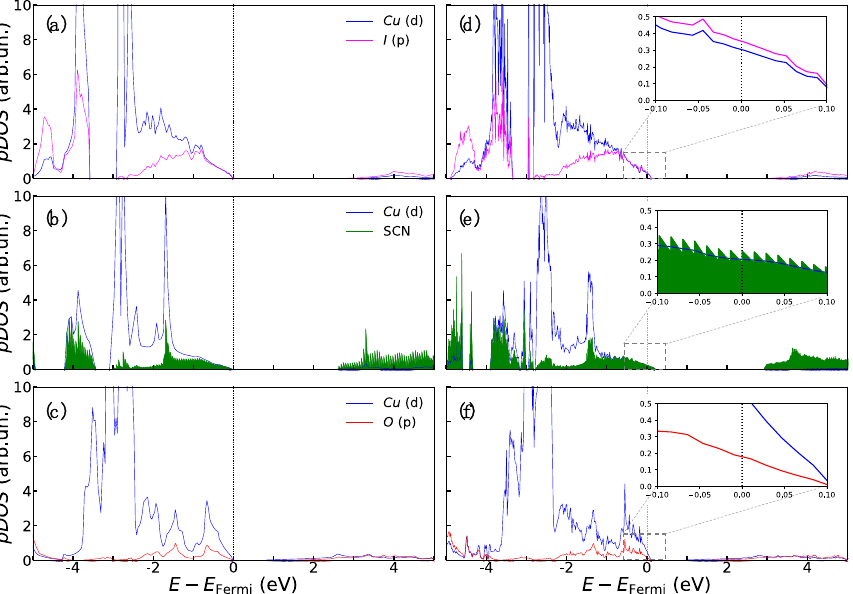
Figure 2. Atom- and orbital angular momentum-projected density of states (pDOS) for the bulk structures of CuI ( a , d ), CuSCN ( b , e ) and Cu 2 O ( c , f ) calculated at the PBE+U level of theory. The pDOS of the left panel refer to pristine bulk structures while those of the right panel pertain to Cu-defective